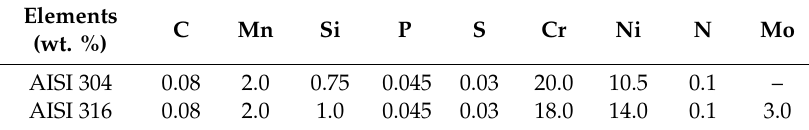
Table 1. Chemical composition of AISI 304 and 316 stainless steel [32].